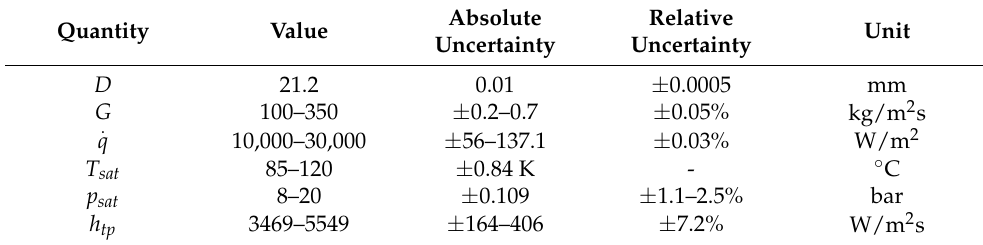
Table 1. Uncertainties of the relevant experimental